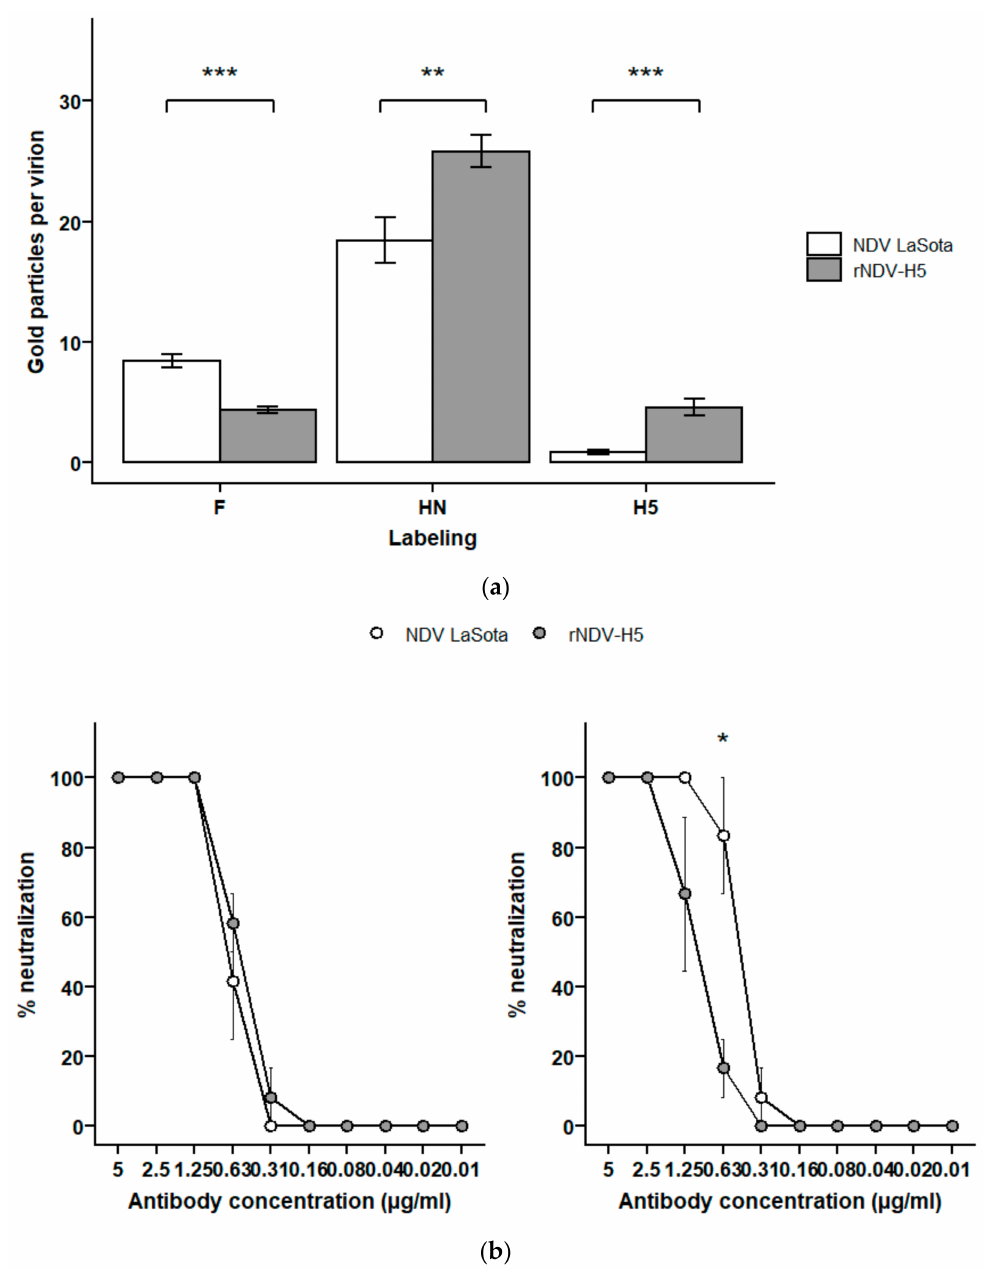
Figure 1. Expression of surface glycoproteins by NDV LaSota and rNDV-H5. ( a ) Proportion of NDV LaSota and rNDV-H5 particles expressing F, HN, and H5. Immunogold labeling of viral particles was performed with anti-HN, anti-F (1C3, IgG1), and anti-AIV H5 (5A1, IgG1) mAbs. The number of gold particles was counted and normalized per virion surface unit of 55,000 nm 2 . Results are expressed as the mean ± standard error of the mean (SEM). ( b ) Comparison of NDV LaSota and rNDV-H5 in a neutralization test using anti-F (left panel) and anti-HN (right panel) monoclonal antibodies. Monoclonal antibodies were two-fold serially diluted and incubated with CEFs for 24 h at 37 ◦ C. Percentages of neutralization are expressed for NDV LaSota (white) and rNDV-H5 (grey) according to the antibody dilutions. * p < 0.05, ** p < 0.01, *** p <